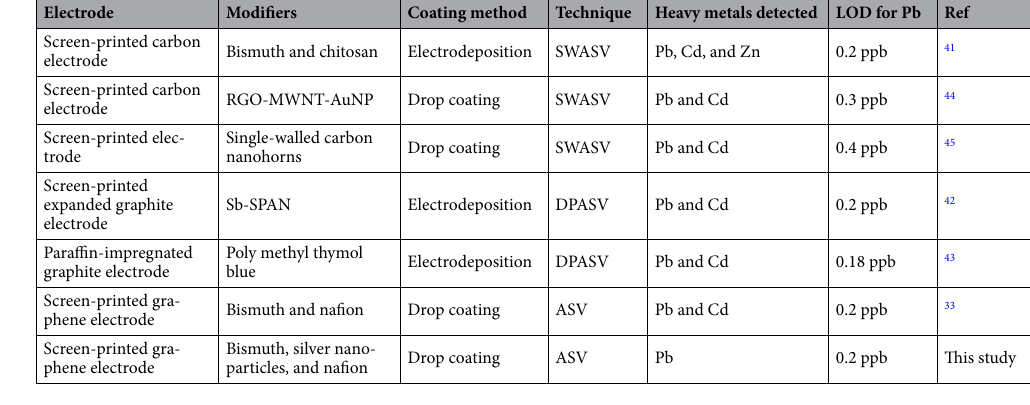
Table 2. Performance comparison of the fabricated modified SPGE with other